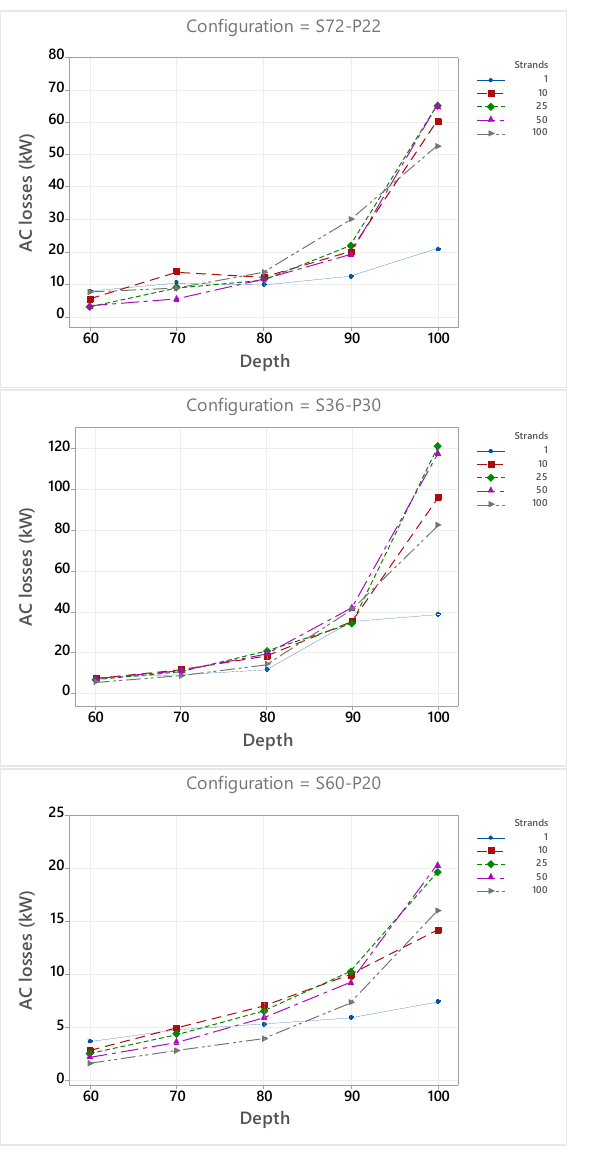
Figure 8. Stranding effect on AC loss map.